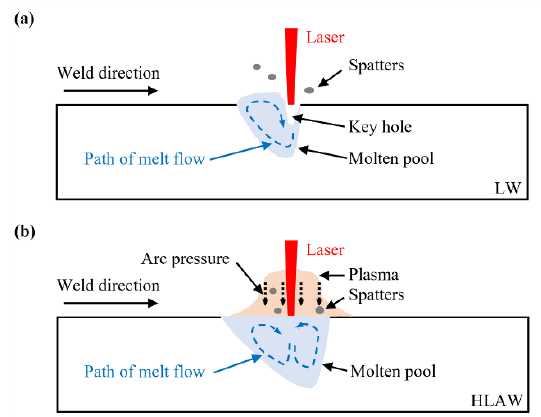
Figure 6. Schematic diagram of molten pool fluctuation mechanism: ( a ) LW; ( b ) HLAW.